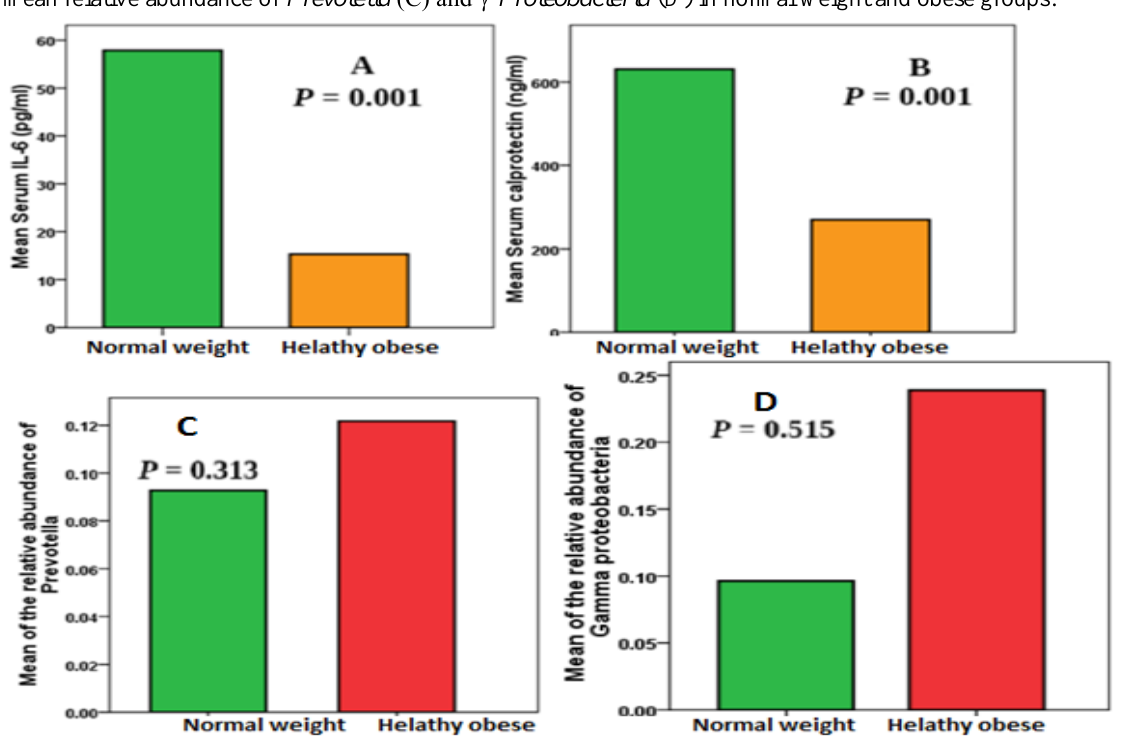
Figure 1. Serum levels of IL-6 (A) and calprotectin (B) in normal weight and healthy obese groups. The mean relative abundance of Prevotella (C) and γ- Proteobacteria (D) in normal weight and obese